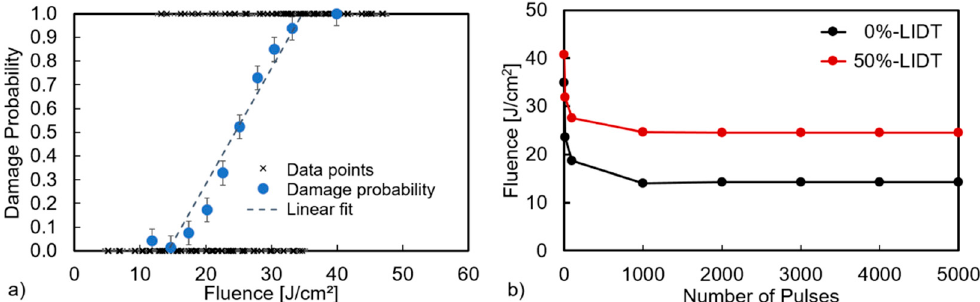
Figure 5. Laser damage testing results of the sample cleaned using process A-CP1: ( a ) damage probability curve and ( b ) characteristic damage curve for the 0% and 50% laser-induced damage threshold (LIDT) as a function of the number of pulses.